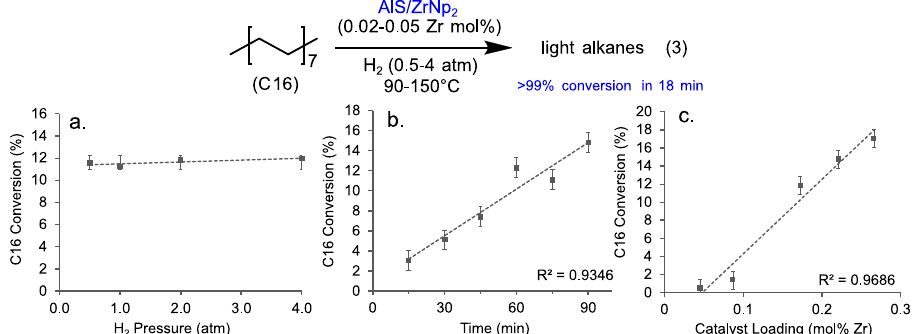
Fig. 4 | Hexadecane (C16) hydrogenolysis data over AlS/ZrNp 2 as a function of reaction parameters. Conditions for all reactions: 120°C, 0.02mol% Zr, 15min, 2.0atm H 2 (350mL vessel), unless otherwise stated. a Conversion as a function of H 2 pressure.Errorbarsrepresent3standarddeviations. b Conversionasafunction